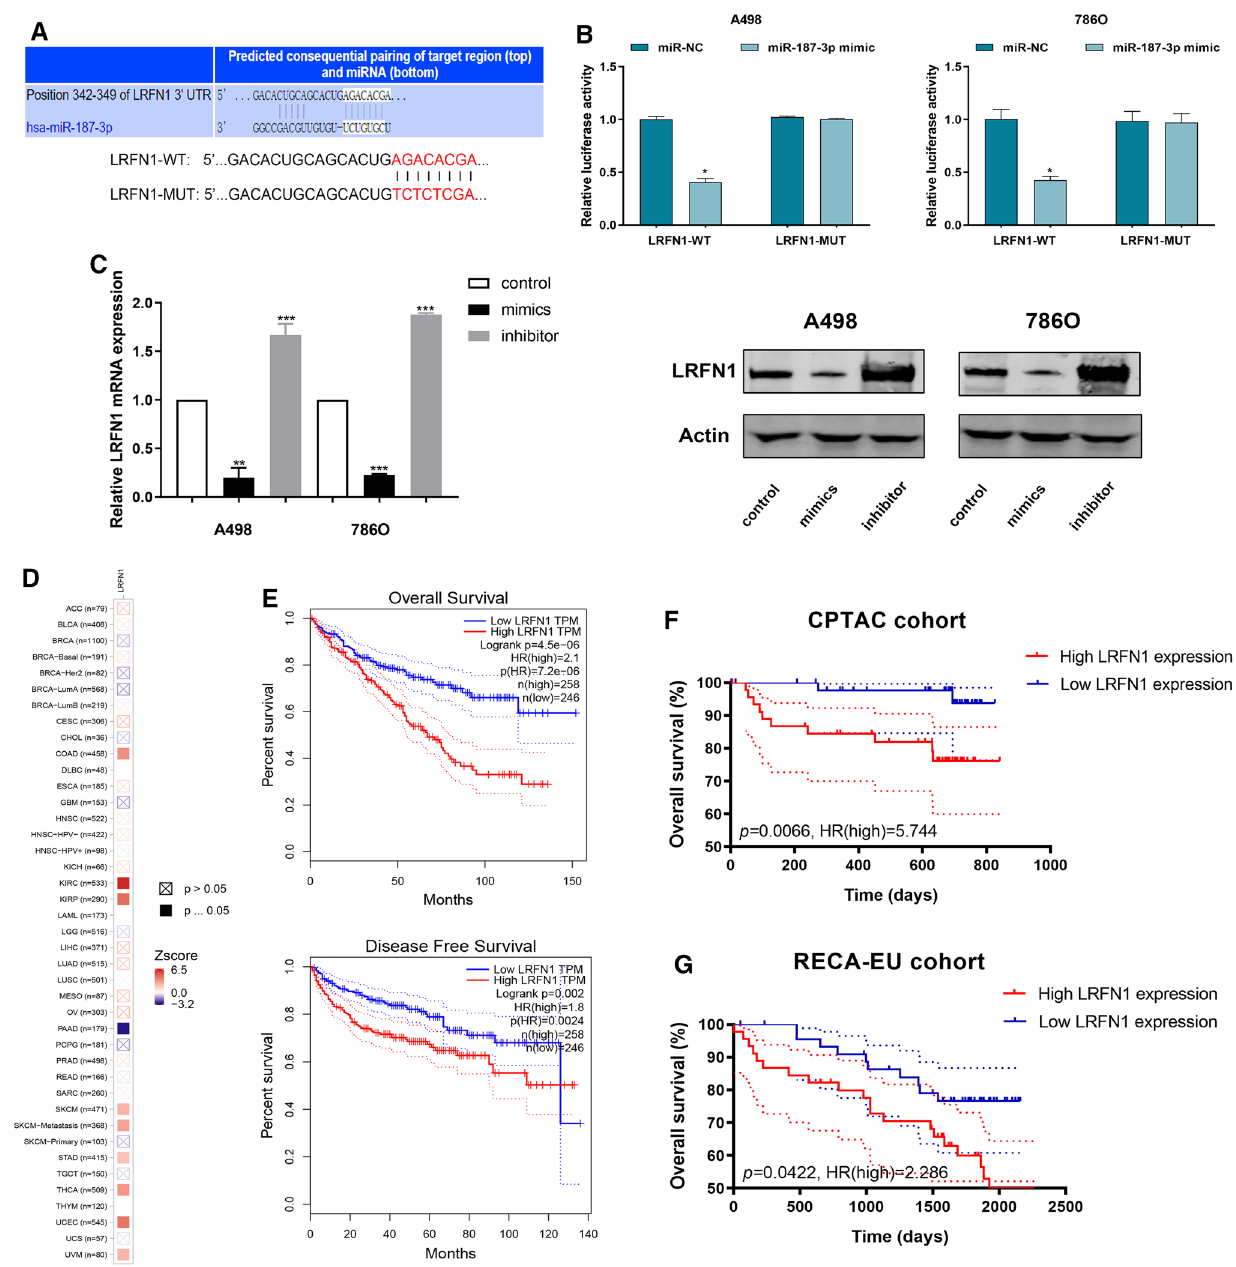
Fig. 3 MiR-187-3p directly targets LRFN1-3 ′ -UTR and modulates the prognostic LRFN1 expression. A A putative binding site of miR-187-3p in the 3 ′ -UTR of LRFN1. B Luciferase assay was performed to investigate whether miR-187-3p binds to a putative binding site in the 3 ′ -UTR of LRFN1. C RT-qPCR and Western Blot were performed to assess the transcriptional and protein expression level alteration of LRFN1. D Prog- nostic implication of LRFN1 in 30 different tumors from TCGA database using log rank test [− log10(P-value)]. E Kaplan–Meier survival plots were used to evaluate predictive value of LRFN1 expression in OS and PFS for 504 patients with ccRCC from TCGA cohort. F Kaplan–Meier survival plots suggested prognostic role of LRFN1 expression for ccRCC patients from CPTAC cohort. G Kaplan–Meier survival plots sug- gested prognostic role of LRFN1 expression for ccRCC patients from RECA-EU cohorts. * P < 0.05; *** P <